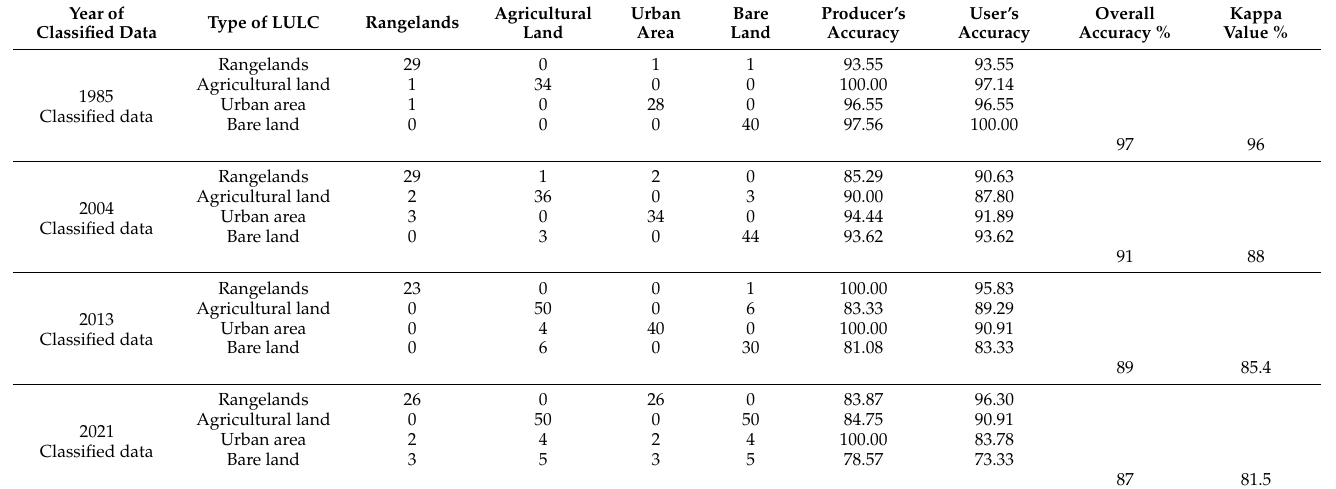
Table 3. Classification accuracy assessment results using error matrix.